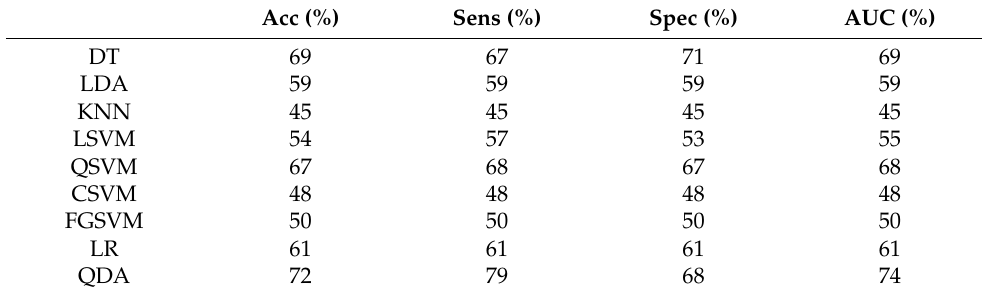
Table 3. Results for the raw data for Dataset